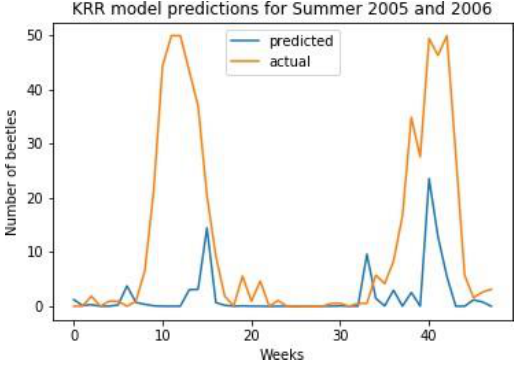
Figure 20. KRR Model predictions for Summer 2005 and 2006